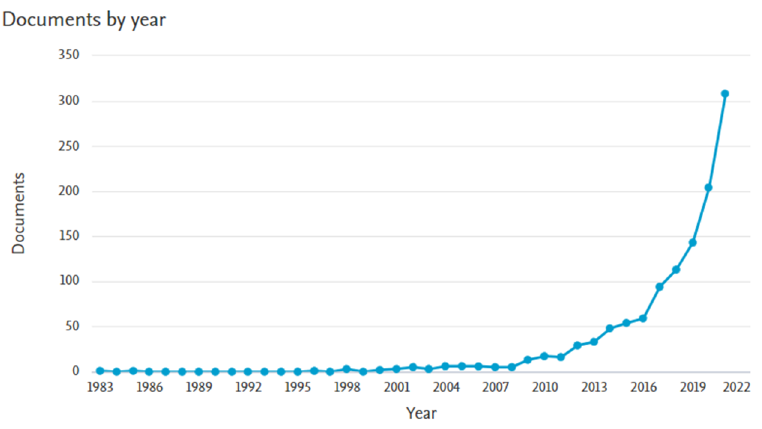
Figure 2. Scopus-indexed publications dedicated to transition strategies in the energy sector as Query 2’s results (Table 1). Source: Scopus database.